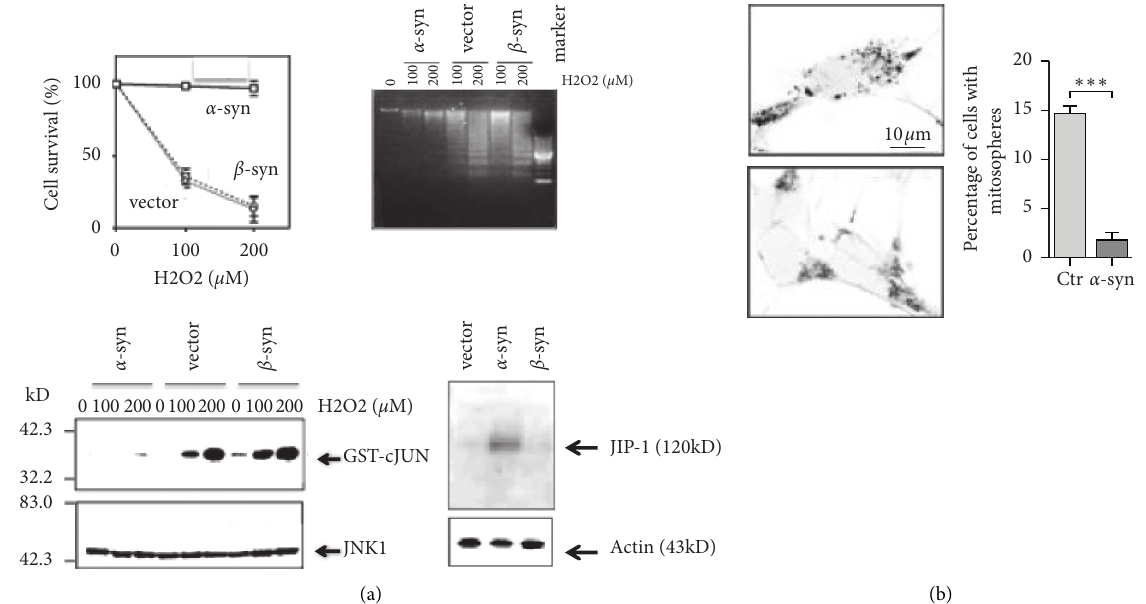
Figure 2: The protective effects of α S against oxidative stress in neuronal cells. (a) α S is shown to protect against oxidative stress via inactivation of the c-Jun N-terminal kinase stress-signaling pathway in GT1–7 neuronal cells [22]. α S-expressing, β S-expressing, and vector- transfected cells were treated with hydrogen peroxide (0, 100, 200 μ m). At 30min of treatment, cells were subjected to immunocomplex kinase assay for the assessment of JNK-1 activity. Note. This JNK activity is downregulated in the α S-overexpressing cells compared to other types of cells. In contrast, immunoblot analysis revealed that expression of JNK-interacting protein (JIP)-1, a JNK-phosphatase, was upregulated in the α S-expressing cells. At 24h, cell survival was determined by the trypan blue exclusion assay and DNA fragmentation assay. Consistent with the results of JNK-1 activity, hydrogen peroxide-treated β S-expressing and vector-transfected but not α S cells displayed DNA fragmentation, as represented by the laddering of genomic DNA. Reprinted from Hashimoto et al. (2002) [22]. (b) In H4 neuroglioma cells treated with hydrogen peroxide, α S was shown to prevent the formation of oxidative stress-induced formation of spherically shaped and hyperpolarized mitochondria, termed “mitospheres,” leading to suppression of apoptosis under the oxidative stress conditions [24]. Reprinted with permission from Menges et al. (2017)